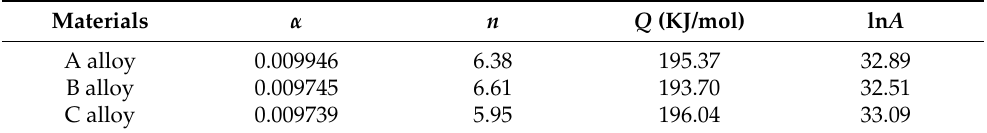
Table 3. Coefficients in constitutive equations.